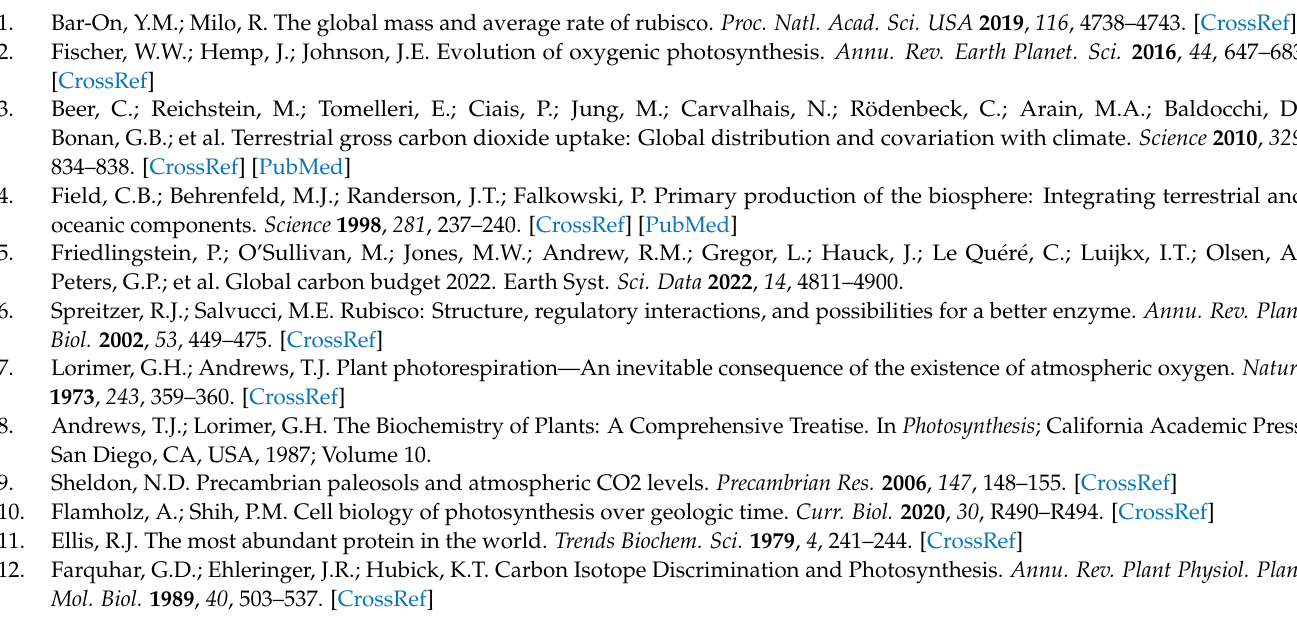
Calculating f from time; Figure S3: Rayleigh plots with equilibrium adjustment; Table S1: Results of rubisco KIE assay; Table S2: Literature compilation of data used to make Figure 1A; Table S3: Additional Specificity and KIE values used for Figure 1B. Table S4: Model outputs for converting time to f